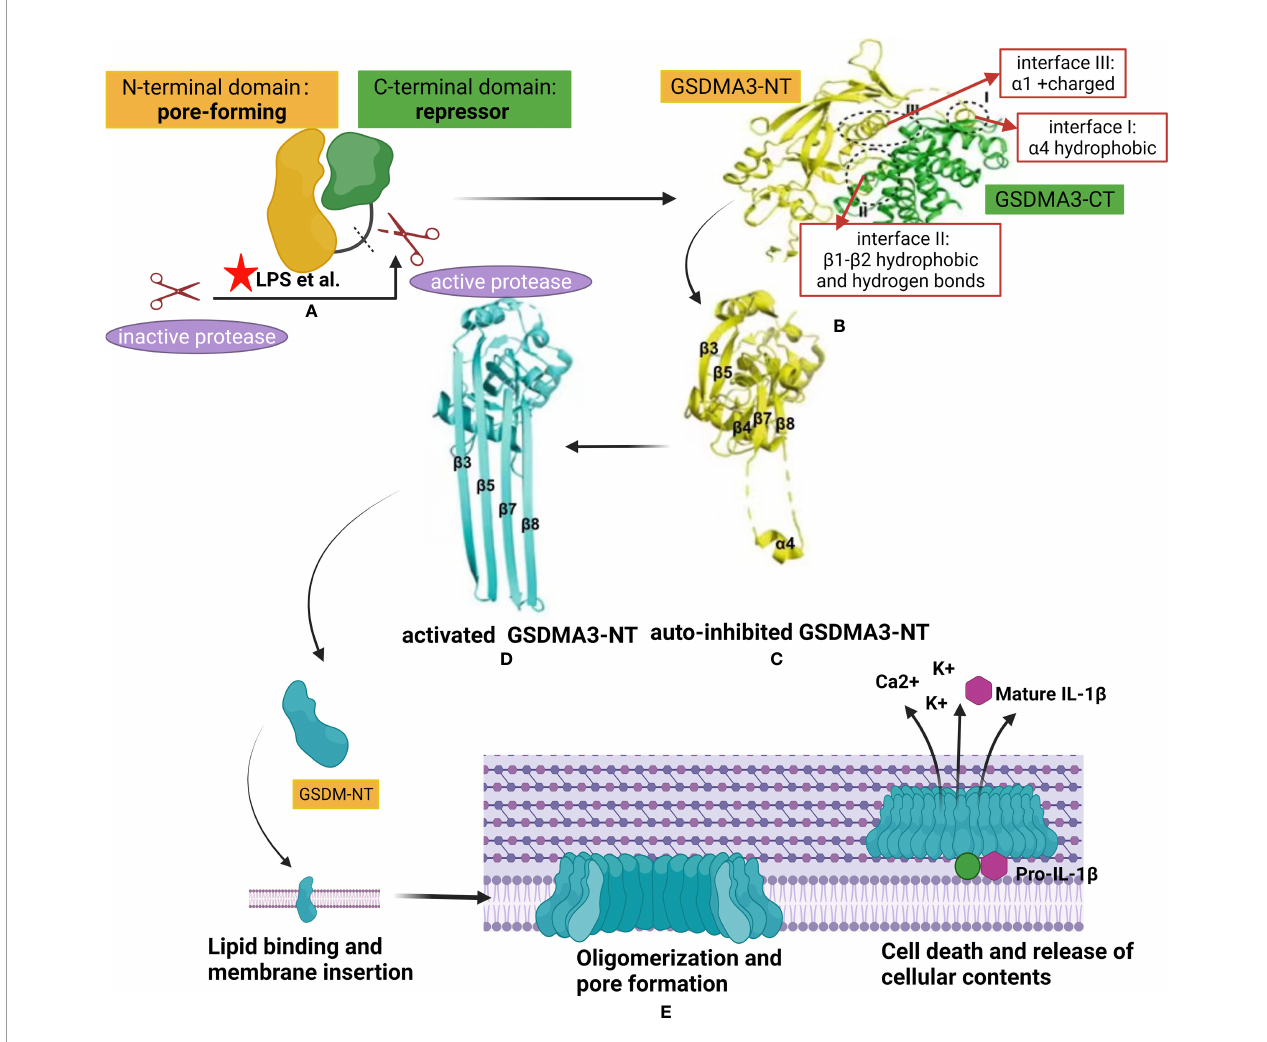
FIGURE 2 | Structural auto-inhibition in GSDM family and mechanism of gasdermin membrane insertion and pore formation. (A) Interdomain interaction between the N-terminal of gasdermin (GSDM-NT) and C- terminal of gasdermin (GSDM-CT), with pore-forming and auto inhibitory characteristics respectively, keeps the full length GSDM protein in an auto-inhibited state. Different proteases, such as in fl ammatory caspases or granzymes, are activated by danger signals from pathogens like lipopolysaccharide (LPS). The latter was represented by a red pentacle in the image. The linker region of GSDMs is cleaved by the active protease releasing the GSDM-NT from the GSDM-CT. (B) (48) X-ray crystal structure of full-length GSDM and the interfaces mediating the inter-domain interactions (I-III) by forming electrostatic, hydrophobic, and hydrogen bonding. The GSDM-NT and GSDM-CT domains are colored yellow and green, respectively. (C, D) (49) Crystal structure of GSDMA3-NT in auto-inhibited conformation (C) and the pore conformation (D) . (E) A proposed universal model showing the pore formation by GSDM family. Once released from the GSDM-CT, the GSDM-NT is recruited to insert in the cell membrane by binding with lipid. Upon membrane binding, the GSDM-N concentrates and starts the oligomerization process forming pores leading to release of cellular contents,including ion fl ux and mature IL-1 b , and fi nally cell